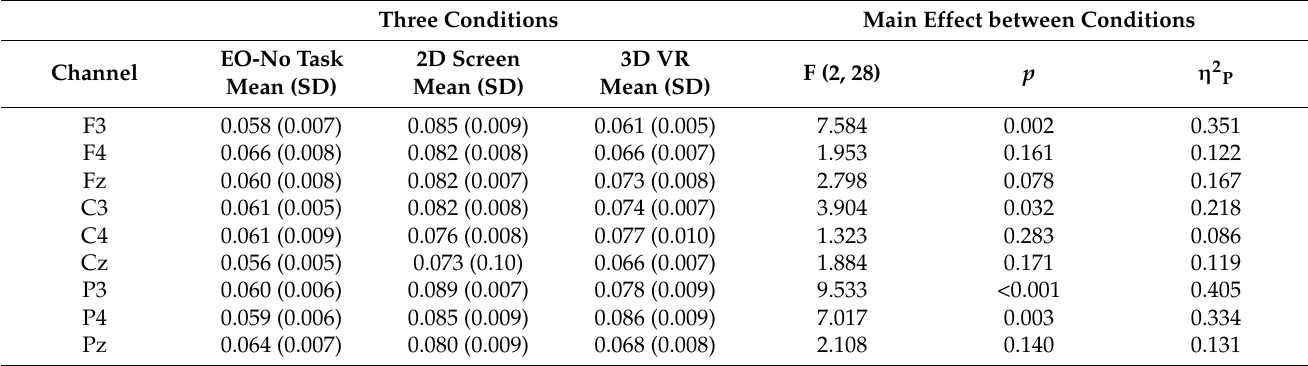
Table 6. Relative EEG gamma power for the three conditions EO-no task, 2D screen and 3D VR. Three Conditions Main Effect between